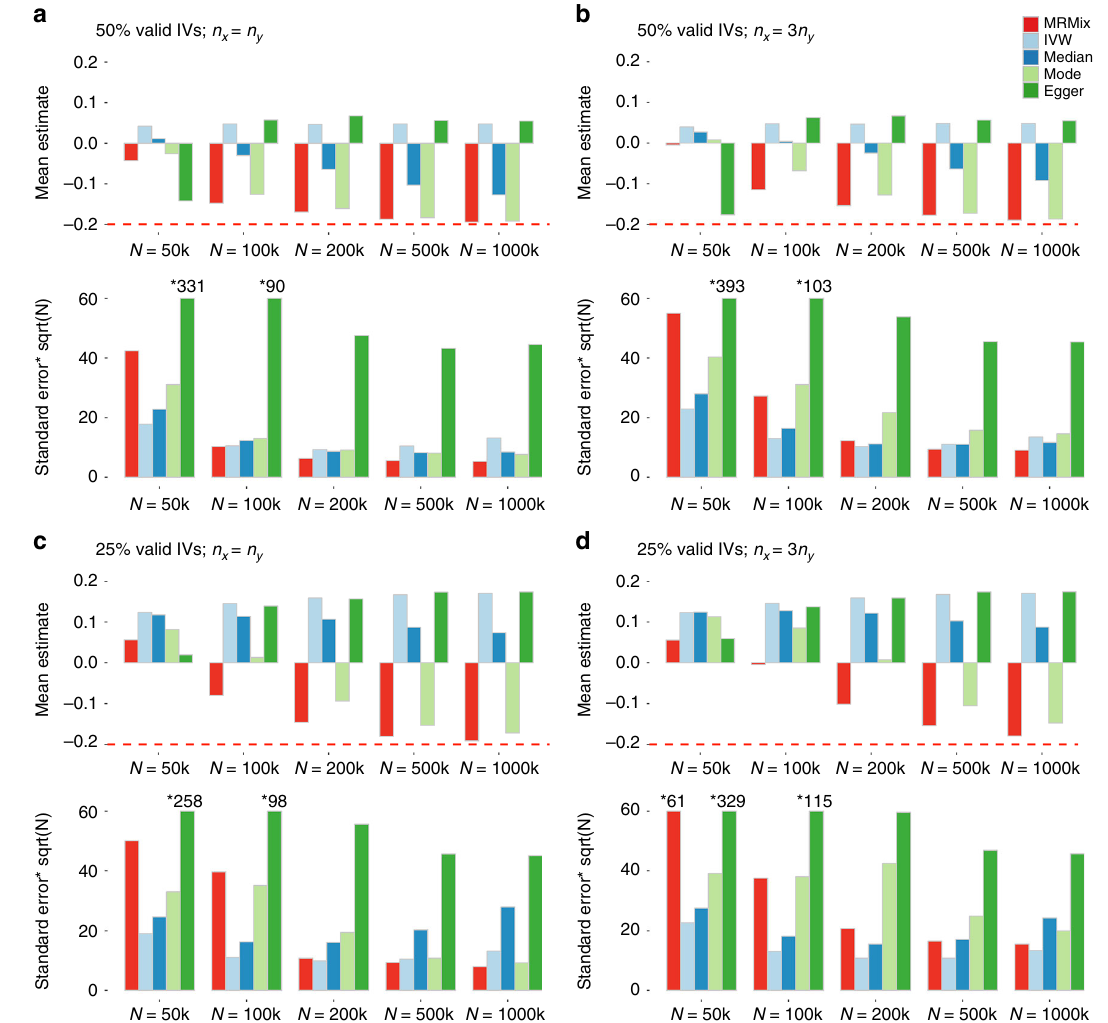
Fig. 3 Simulation results when genetic correlation due to causal and pleiotropic effects are in opposite directions. Mean and standard deviation of causal estimates are reported over 100 simulations. The true causal effect θ = − 0.2. Estimates of association coef fi cient for SNPs across two traits are simulated assuming an underlying four-component model for effect-size distribution (Scenario A, see Methods), where SNPs could have direct effects on neither traits, only on X , only on Y , or on both with the effects being correlated. The proportion of valid instruments, i.e. the SNPs which have only direct effects on X as a proportion of the total number of SNPs which are associated with X , are fi xed at 50% or 25%. n x = N : sample size of the study associated with X ; n y : sample size of the study associated with Y . Standard error bars higher than 60 are truncated and marked with *true-value. The average number of IVs, de fi ned as the SNPs which reach genome-wide signi fi cance (z-test p < 5 × 10 − 8 ) in the study associated with X , is 14, 105, 399, 1135, and 1780 for N = 50 k, 100 k, 200 k, 500 k and 1000 k, respectively. Source data are provided as a Source Data fi